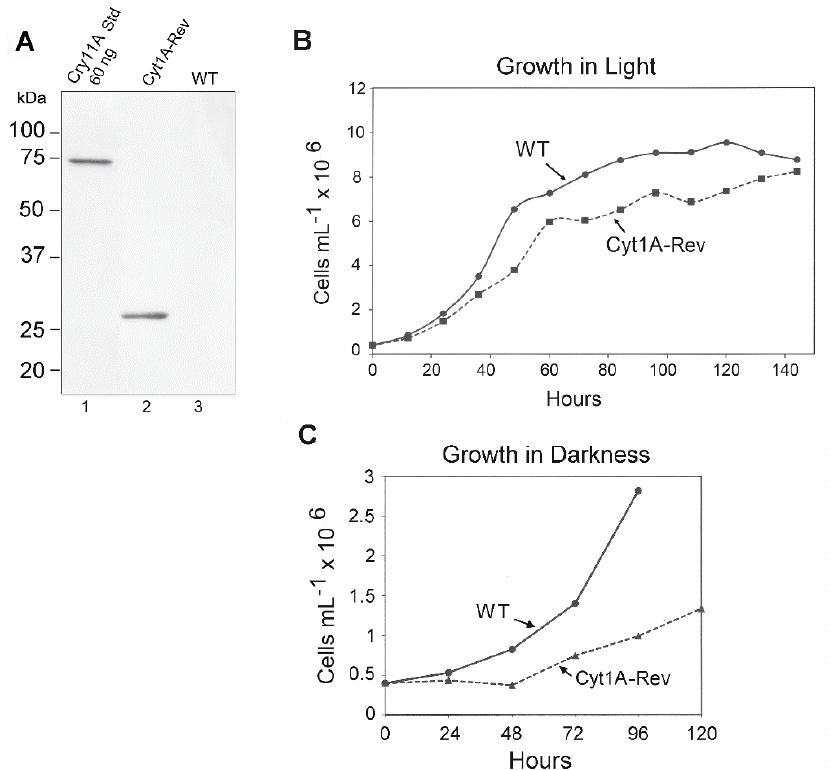
Figure 5. Western blot and growth rate analysis of the Cyt1Aa-Rev/CC-1690 transformant. ( A ) Western blot analysis of the Cyt1A-Rev transformant and the control WT strain (CC-1690); lane 1 contained ~60 ng of the FLAG-tagged Cry11Aa standard protein. The lanes were loaded with 20 µg of Chlamydomonas protein, including lane 1, which received 20 µg of WT protein. ( B ) Growth curves for the Cyt1A-Rev transformant (in CC-1690) and WT strain (CC-1690) in continuous light. The cells were grown in TAP medium in continuous light as described in Methods. At the indicated times, aliquots (1 mL) were withdrawn, and total chlorophyll was quantified and converted to cell density. ( C ) Growth curves for the Cyt1A-Rev transformant (in CC-1690) and WT strain (CC-1690) in continuous darkness. The cells were grown in TAP medium as described in Methods, except in continuous darkness. Total chlorophyll was quantified on aliquots removed at the indicated times and converted to cell density.